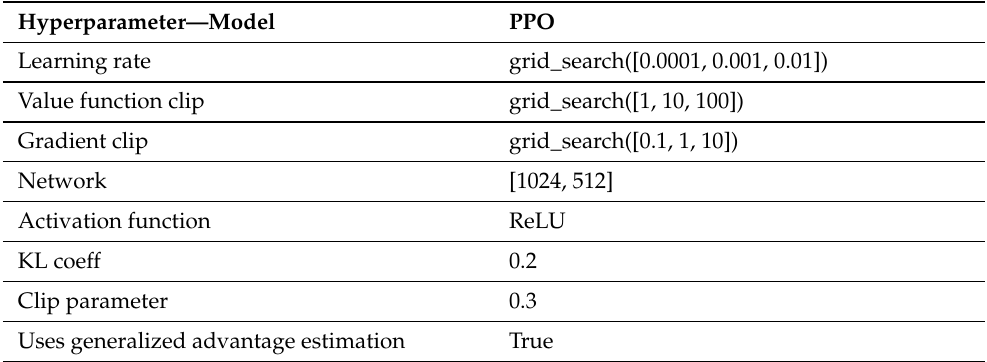
Table 4. Hyperparameters for the PPO